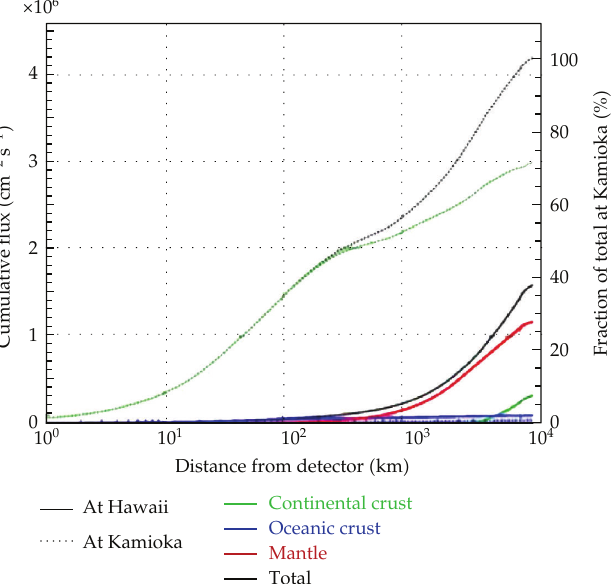
Figure 7: Cumulative geoneutrino flux within a given distance from a detector, for observation at Kamioka (cid:5) continental site (cid:6) and Hawaii (cid:5) oceanic site (cid:6) . Reprinted from (cid:3) 36 (cid:4) with permission from